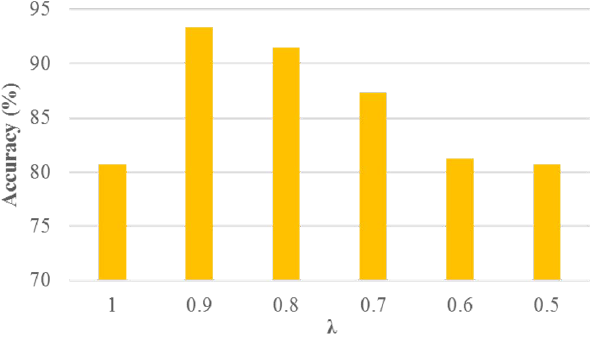
Figure 5. The classification accuracies (%) of the proposed JFCNN with different λ